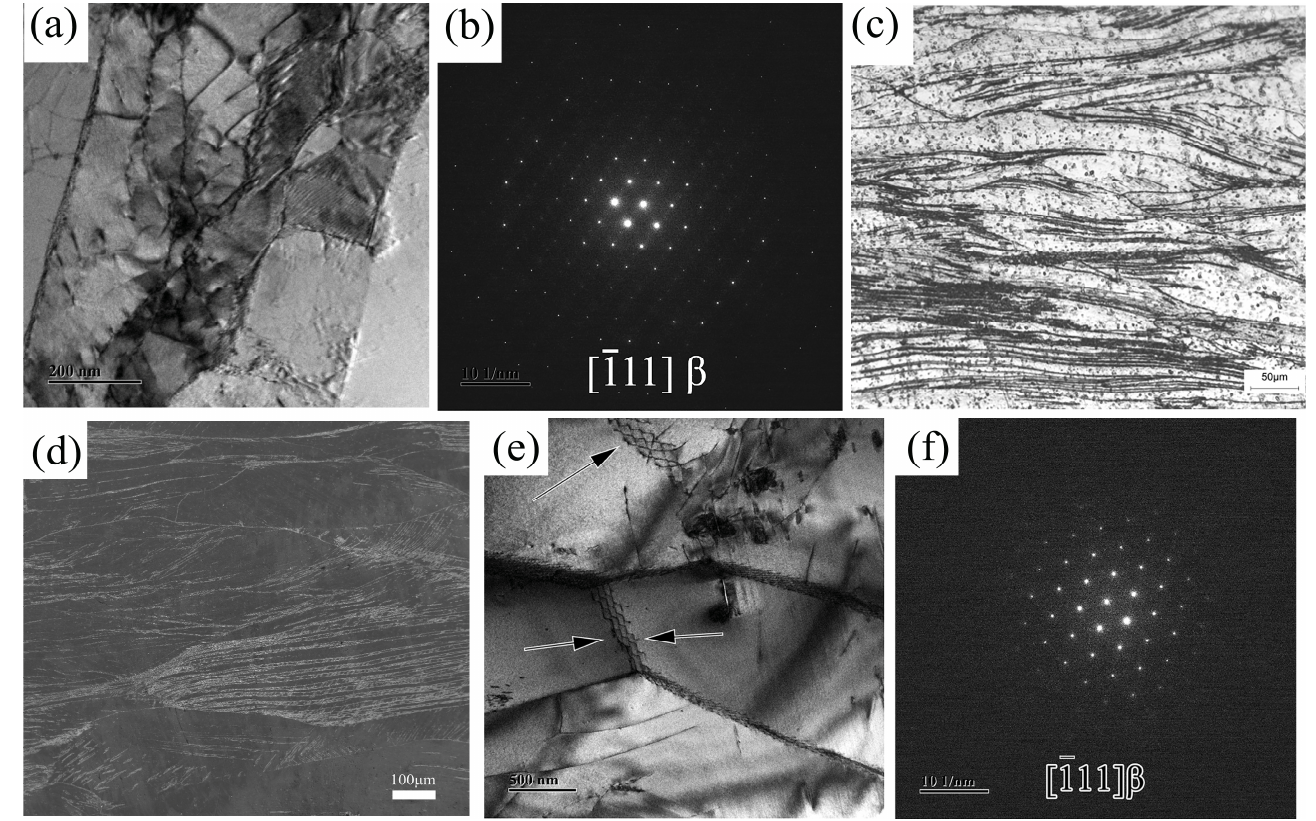
Figure 6. ( a ) rolling alloy: TEM image; ( b ) rolling alloy: diffraction spots; ( c ) rolling alloy: OM image; ( d ) rolling alloy: SEM image; ( e ) 800 °C annealing alloy after the tensile test: TEM image; ( f ) 800 °C annealing alloy after the tensile test: diffraction spots.